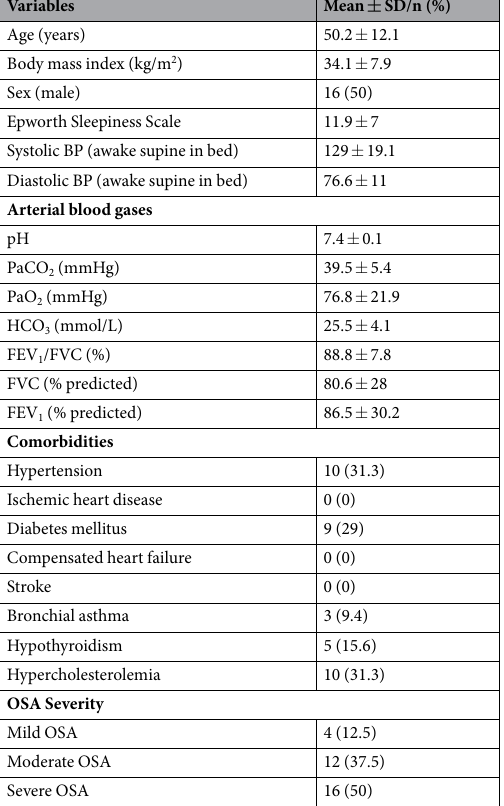
Table 1. Demographic and general information of patients. A total of 32 patients participated in this study. BP, blood pressure; OSA, obstructive sleep apnea; FVC, forced vital capacity; FEV, forced expiratory volume.